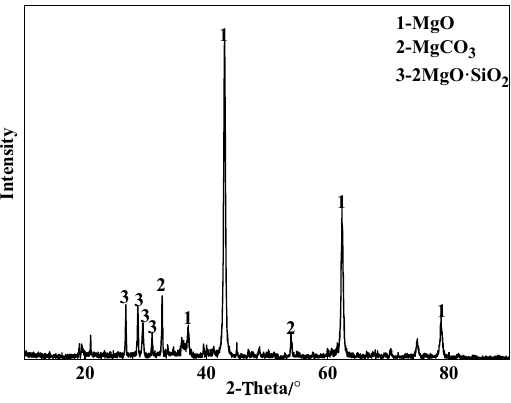
Table 1. Chemical composition of LCM (mass, %).